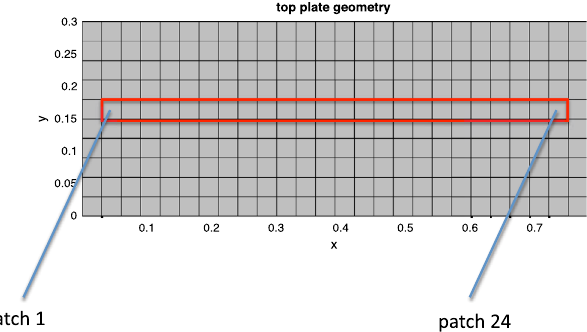
Figure 6. Position of possible sources in front of the